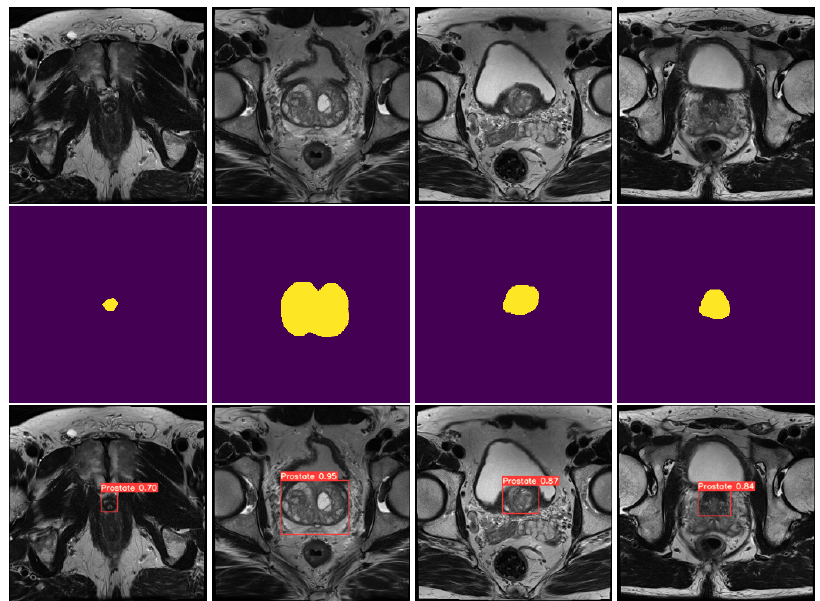
Figure 3. Comparison between original prostate images, masks and predicted volumes. The top row consists of random slices from different volumes, the second row consists of the respective prostate masks, and the third row consists of the respective predicted bounding boxes, with confidence value of the prostate on each of the